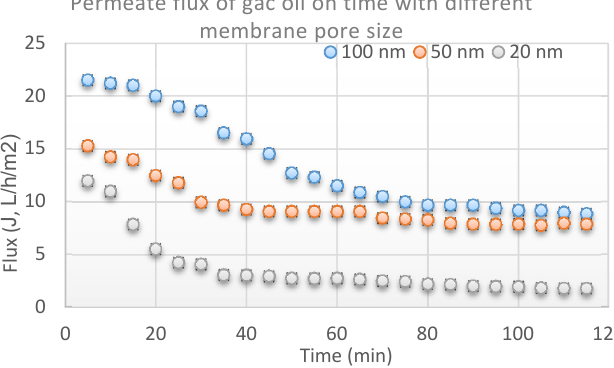
Figure 14. Permeate flux of gac oil on time with different membrane pore sizes ( T = 30 °C; TMP = 2 bars). Table 5. Effect of membrane pore size on coefficient of retention of TCC in retentate. Membrane Pore Size (nm)